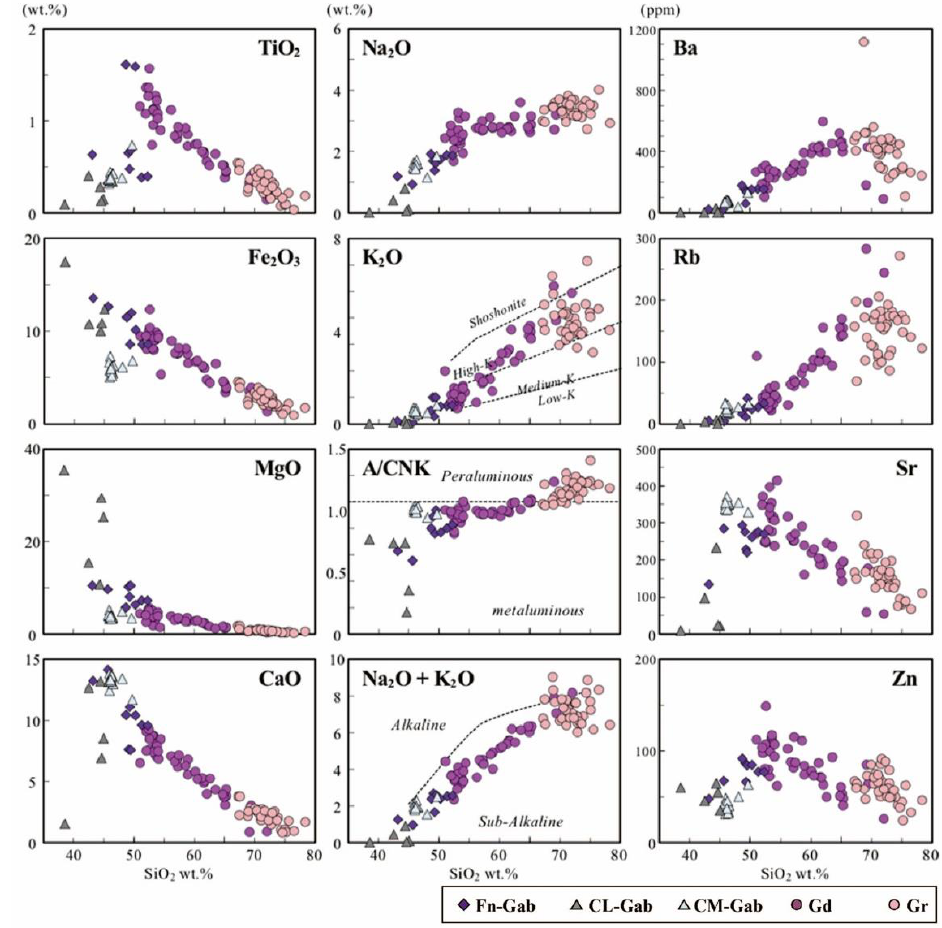
Figure 6. Variation diagrams of the SNPC. Gd, granodiorite; Gr, granite. The granodiorite and granite show different trends in SiO 2 – Sr and – Zn diagrams.